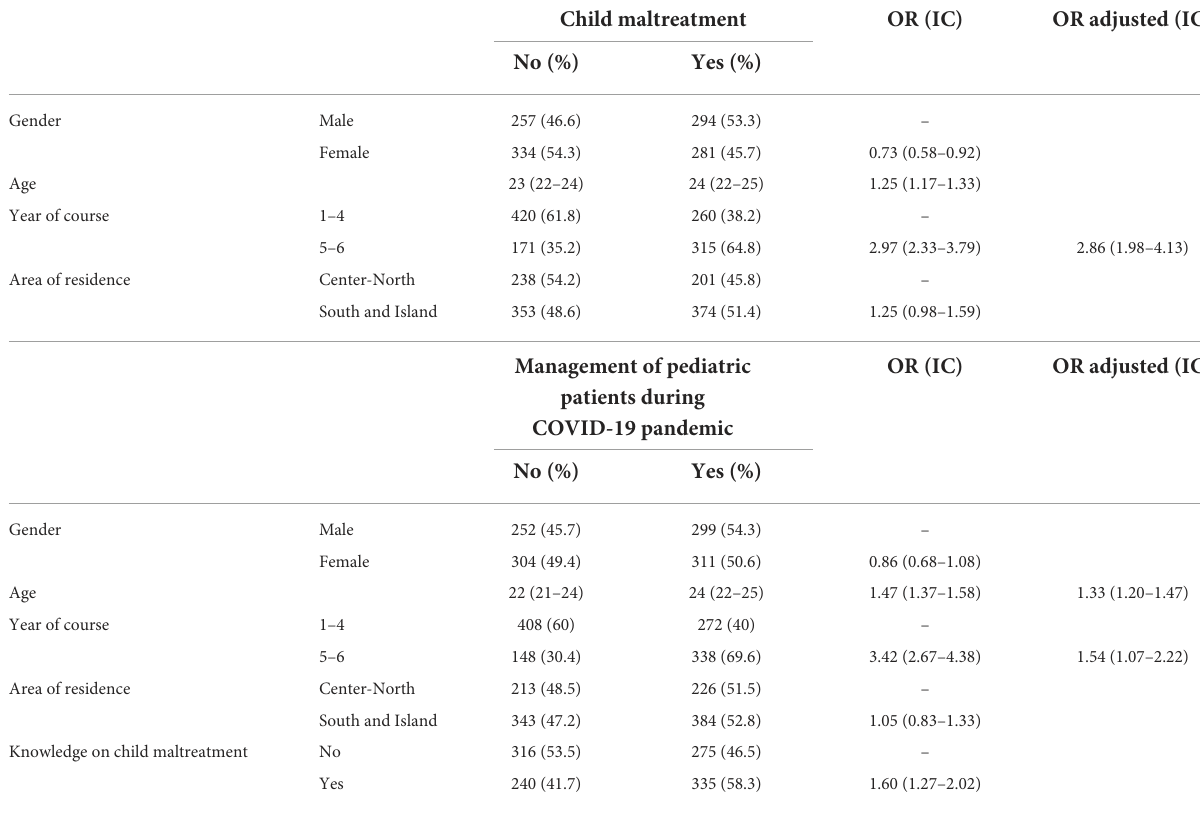
TABLE 3 Knowledge and attitudes on child maltreatment and management of pediatric patients during COVID-19 pandemic (adjusted OR , Odds Ratio; CI , 95% confidence interval).